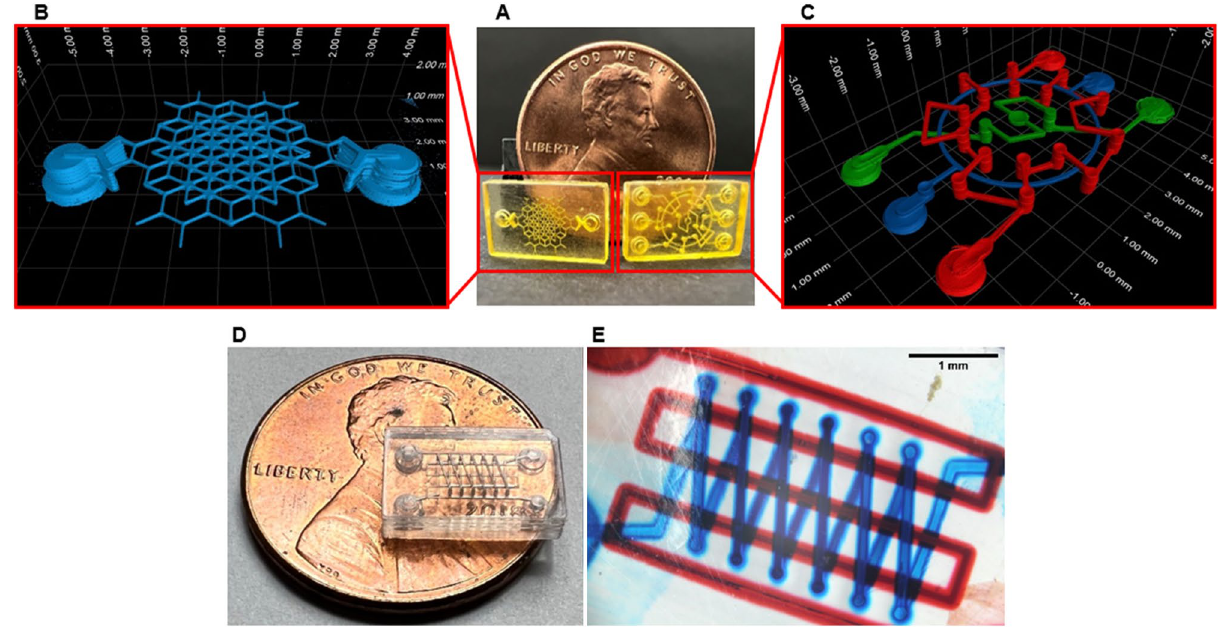
Figure 5. 3D printed microdevices comprising of complex hollow geometries. ( A ) Picture of devices fabricated using a HDDA based resin. The hollow regions of these devices were characterized using Nano-CT imaging, for which the renderings are shown in ( B ) and ( C ). ( B ) Device comprised of channels (blue) with connected paths that form hexagonal geometric patterns (designed height of 100 μm and width of 75 μm). ( C ) Device comprised of multiple channels (designed height of 150 μm and width of 100 μm) spanning across all three-dimension of the device (multilevel channels). Each continuous channel path is colorized (red, green, blue) to illustrate that the intricate channels are separate but are interlocked. The computer-aided design (CAD) model of this device is shown in Supplementary Fig. 4. ( D ) Microscope picture of an optically transparent device comprising of multilevel channels (designed height of 250 μm and width of 125 μm) fabricated using a PEGDA based resin. ( E ) The channels of the device shown in ( D ) are filled with colored food dyes to illustrate functionality for microfluidic applications. The CAD model of the device in ( D ) and ( E ) is shown in Supplementary Fig.